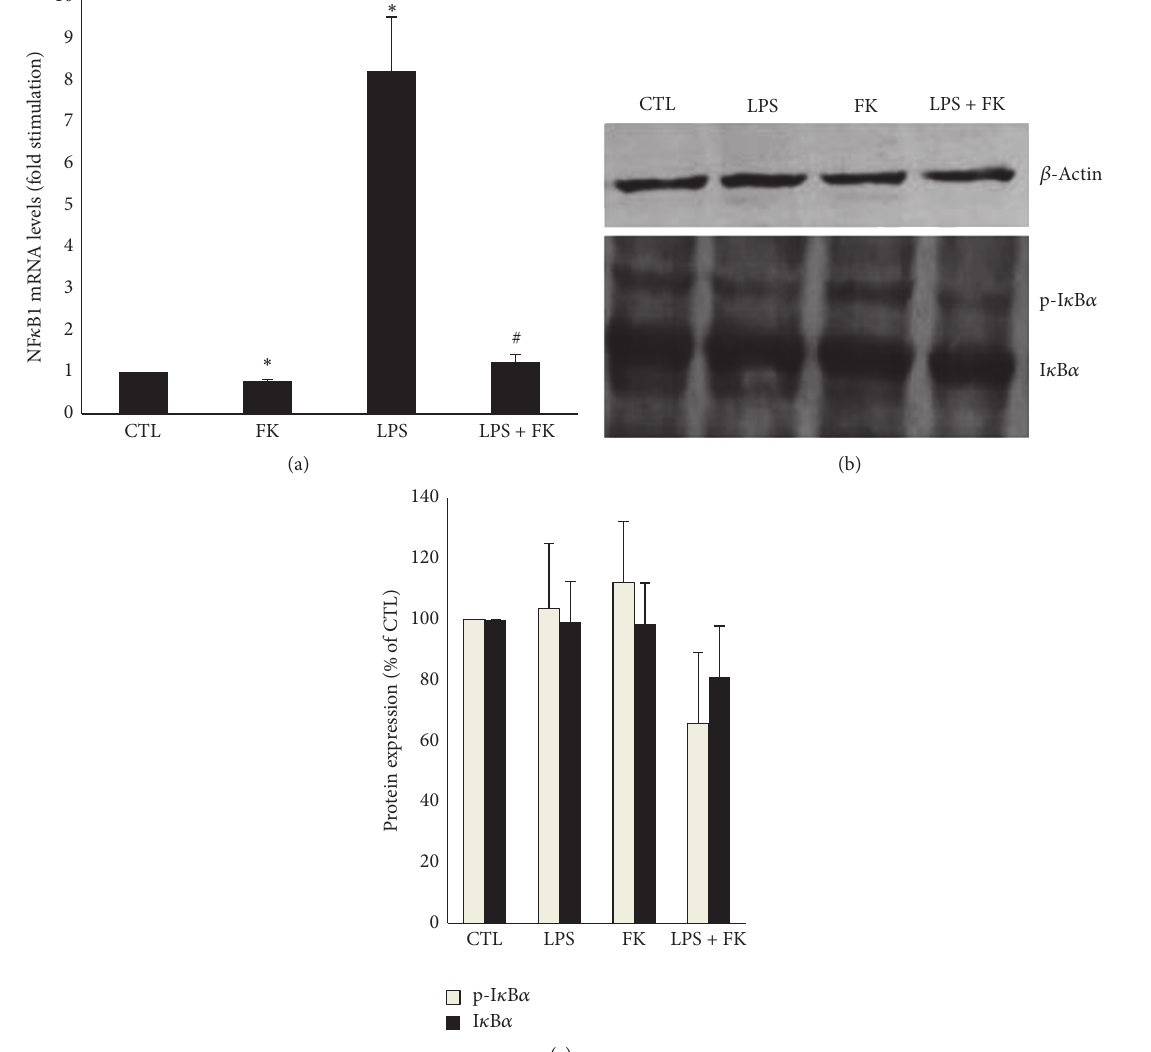
Figure6:NF 𝜅 B1mRNAandI 𝜅 B 𝛼 proteinlevelsindifferentiated3T3-L1cellstreatedwithLPSintheabsenceorpresenceofFK.Differentiated 3T3-L1 cells were treated as described in Materials and Methods under the following conditions: CTL, 10 𝜇 M FK, 1 𝜇 g/mL LPS, and LPS + FK. (a) The results are expressed as mRNA levels (fold stimulation over CTL set to 1). (b) Phospho-I 𝜅 B 𝛼 and total I 𝜅 B 𝛼 protein levels were determined in DC by Western blot analysis. (c) Semiquantitative determination of protein expression was performed as described under Materials and Methods. The results are expressed as protein expression (ratio of total I 𝜅 B 𝛼 or P-I 𝜅 B 𝛼 band density over 𝛽 -actin band density) expressed as percent of the CTL value (CTL set to 100%) and are the mean ± SEM ( 𝑛 = 3 ) (in % of CTL). Data were analyzed using 𝑡 -test for unique sample and paired 𝑡 -test; ∗ 𝑝 < 0.05 versus CTL; # 𝑝 < 0.05 versus